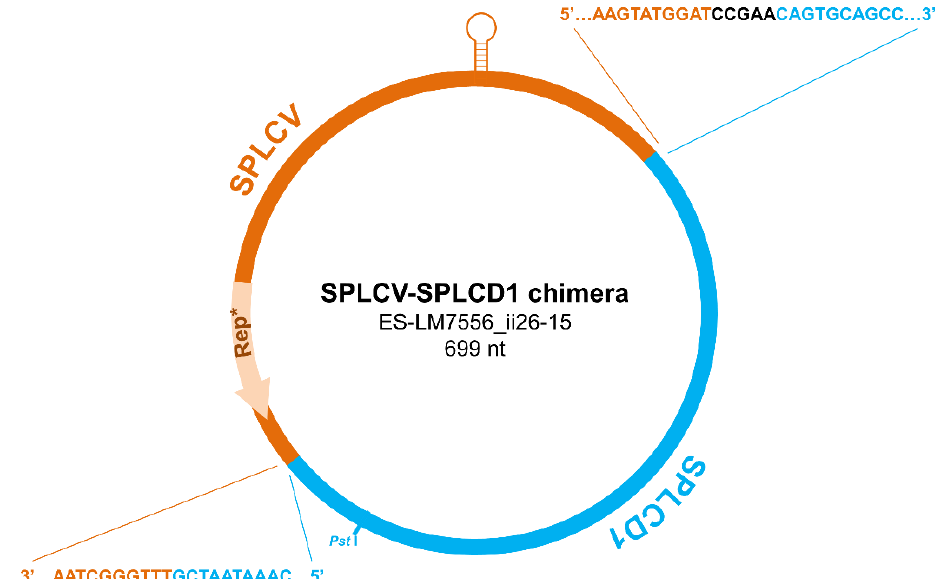
Figure 4. Schematic representation of the chimeric sweepovirus-deltasatellite molecule identified in an Ipomoea indica plant from M á laga province (sample ii26). The viral moiety (partial sequence of sweet potato leaf curl virus including a truncated replication-associated protein, Rep *) is represented in orange, and the deltasatellite moiety (partial sequence of sweet potato leaf curl deltasatellite 1) is represented in blue. Nucleotides in black (CCGAA) are not present in the putative parental sequences. The stem-loop structure containing the conserved nanonucleotide TAATATTAC is shown at the top of the graph. The restriction site used for cloning is indicated ( Pst